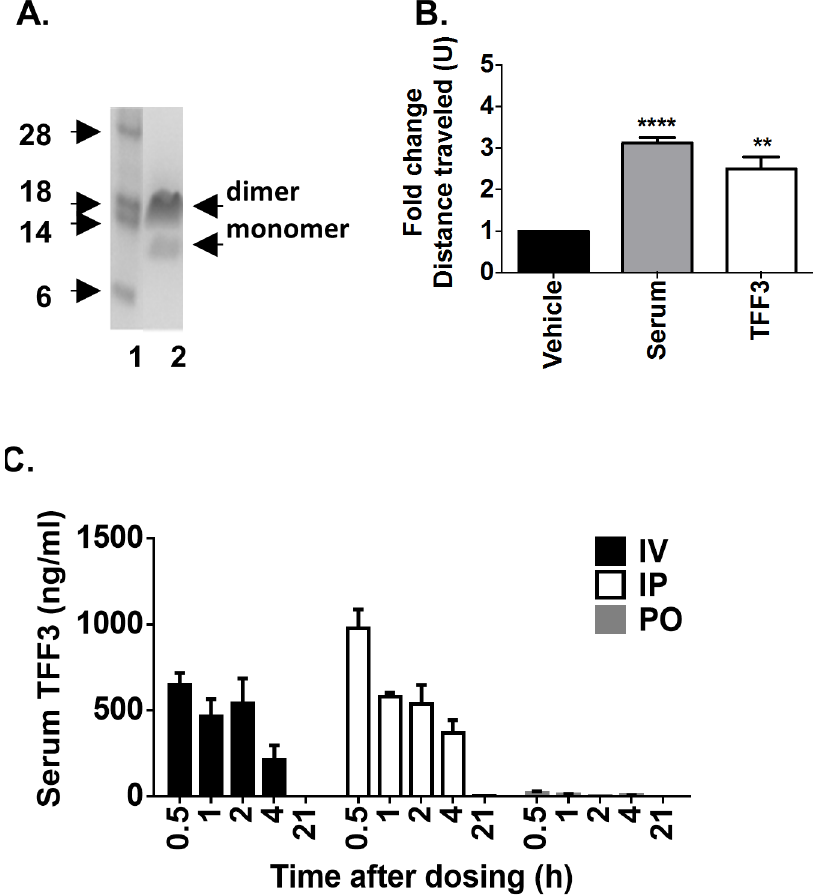
Fig 3. Production and characterization of recombinant TFF3 protein. (A) SDS-PAGE showing M.W. markers (lane 1) and recombinant TFF3 (lane 2). The 14 kDa band represents a TFF3 dimer and the 7 KDa band a monomer. (B) TFF3 protein was tested in an in vitro wound healing assay and compared to cells receiving vehicle alone or serum-supplemented medium. Results are shown as fold of migration distance when compared to treatment with vehicle only. (C) Pharmacokinetic properties of recombinant human TFF3 after administration in BDF-DIO mice intravenously, IV, intraperitoneally, IP, or per oral gavage, PO. ** p < 0.01 and **** p <